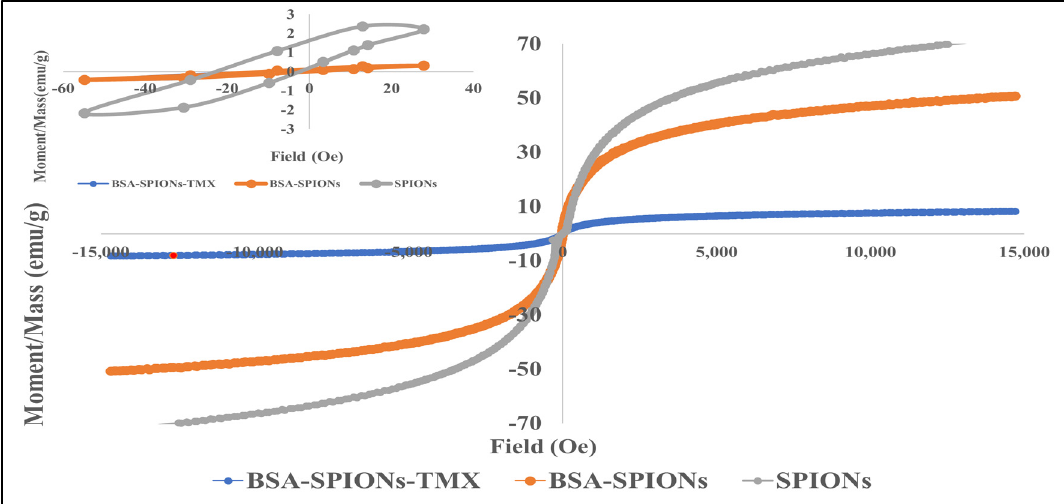
Figure 3. Field dependence of magnetization green synthesized SPIONs, BSA-SPIONs, and BSA- SPIONs-TMX measured in the applied magnetic field (Oe) at room